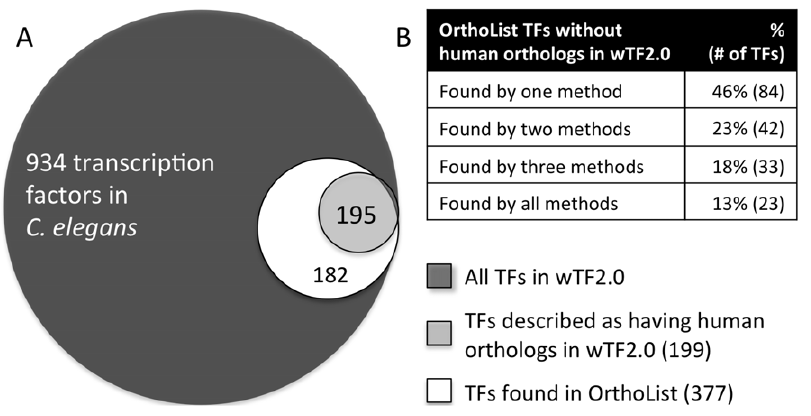
Figure 5. OrthoList coverage of a transcription factor compendium. A) Venn diagram comparing the wTF2.0 compendium [45] to OrthoList. Source data for this diagram is found in Tables S9A, B. We find that OrthoList contains , 98% of TFs previously scored as having human orthologs (overlap). In addition, OrthoList contains 182 TFs not scored in wTF2.0 as having orthologs. B) Distribution of TFs found to have orthologs by OrthoList, but not by wTF2.0. Source data for this table is found in Tables